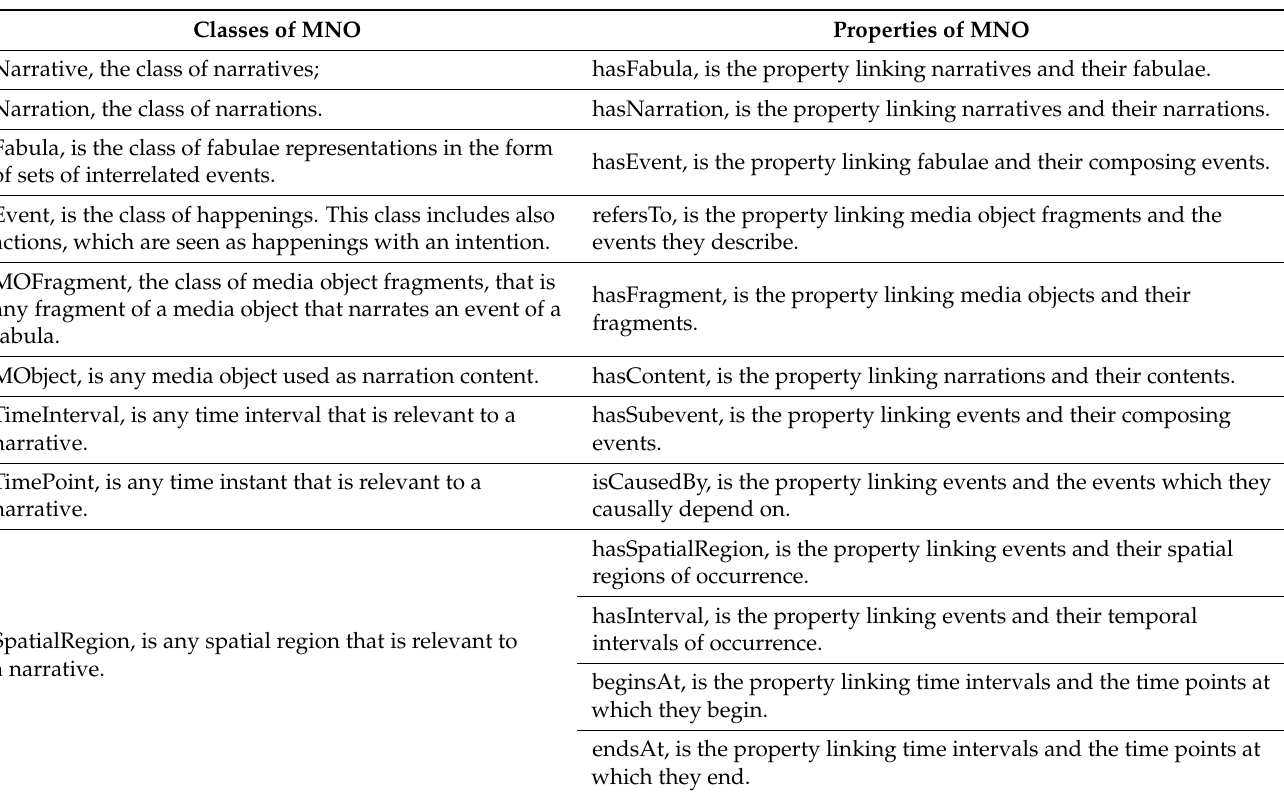
Table 2. Classes and properties of the Narrative Ontology.